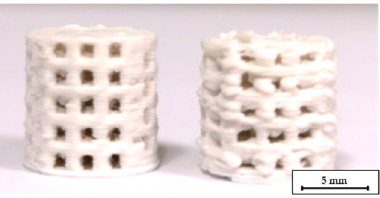
Figure 5. C2 based scaffolds printed at 205 °C, for the left one a 0.4 mm nozzle was used, for the right one a 0.5 mm nozzle.